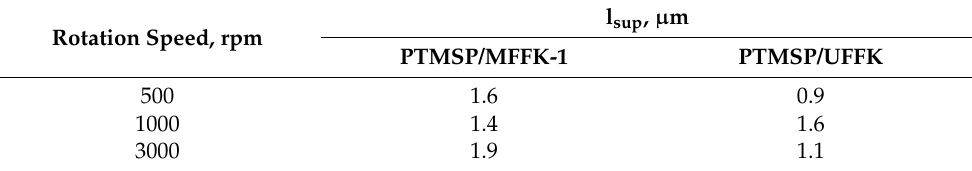
Table 5. Estimated by EDX PTMSP penetration depth into the pores of the support (l sup ) for com- posite membranes obtained by applying PTMSP solution in chloroform (C = 0.35 wt %) at different rotation